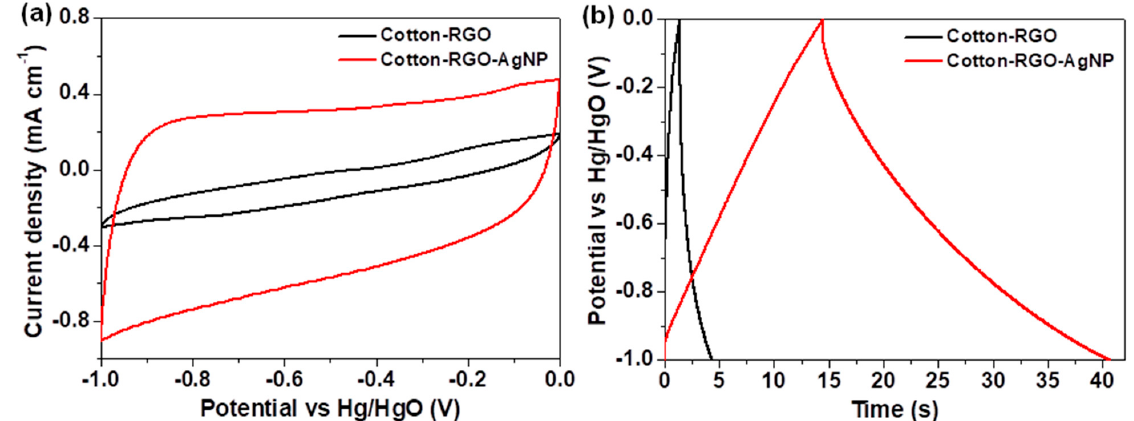
Figure 5. Comparison of electrochemical properties between cotton-RGO and cotton-RGO-AgNP fiber electrodes. ( a ) The CV tests conducted at 50 mV·s − 1 ; ( b ) the GCD tests carried out at 0.5 mA·cm − 1 .